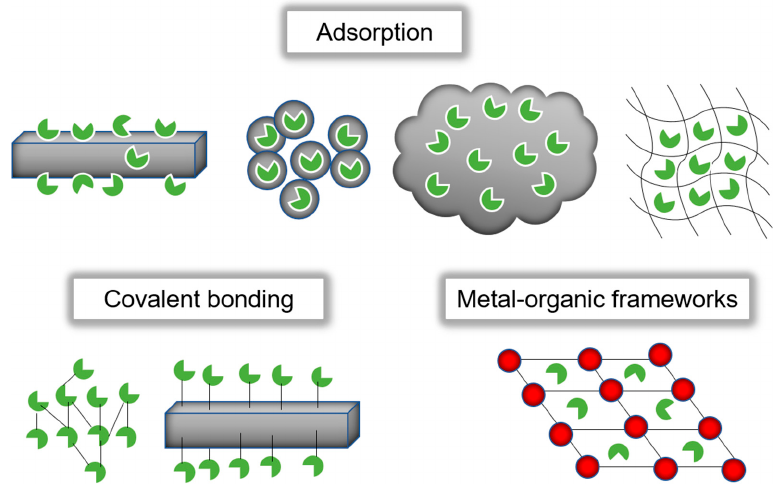
Figure 1. Schematic of various carriers for immobilization of enzymes.